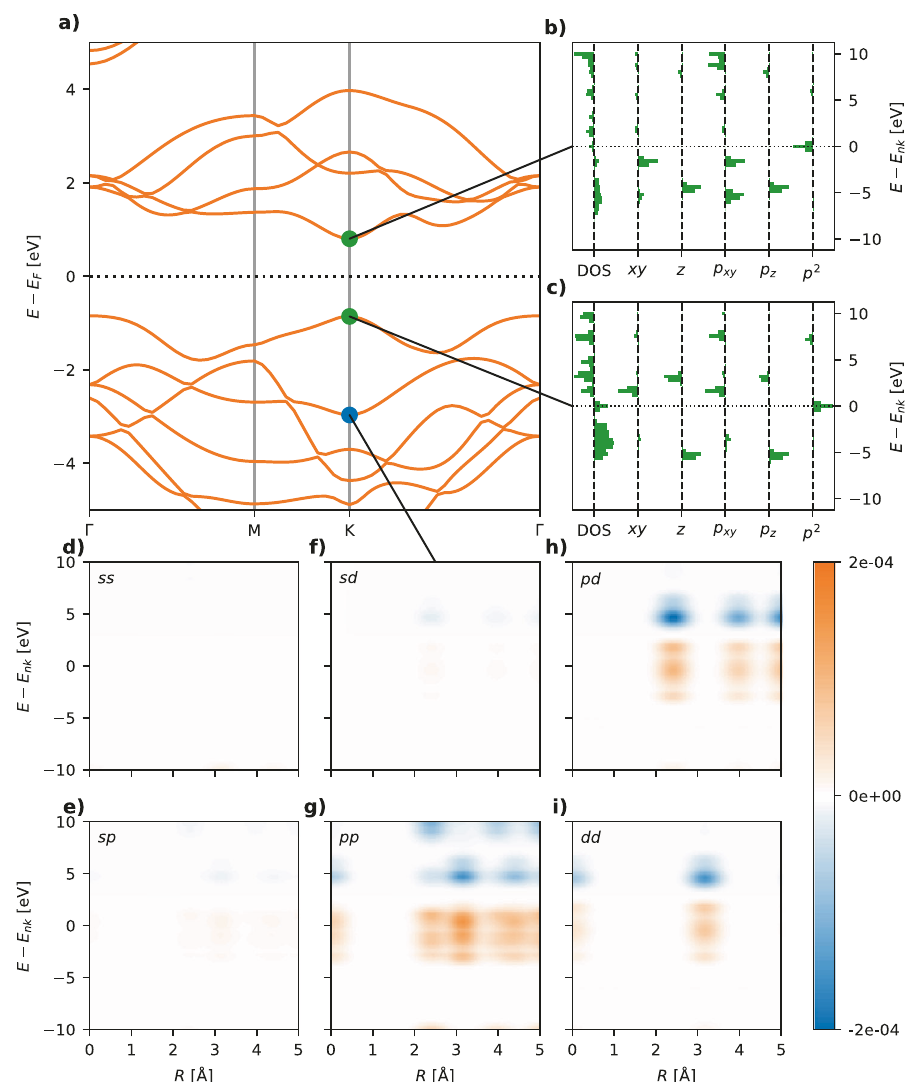
Fig. 2 Visualization of electronic state fi ngerprints for MoS 2 . a Shows the PBE band structure. b , c Show ENDOME fi ngerprints of the conduction band minimum and valence band maximum states for the K-point. d – i Show six RAD-PDOS fi ngerprints for combinations of s , p , and d